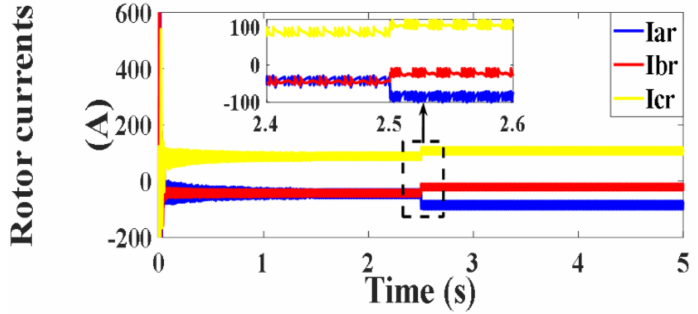
Figure 36. Rotor currents under MPCC